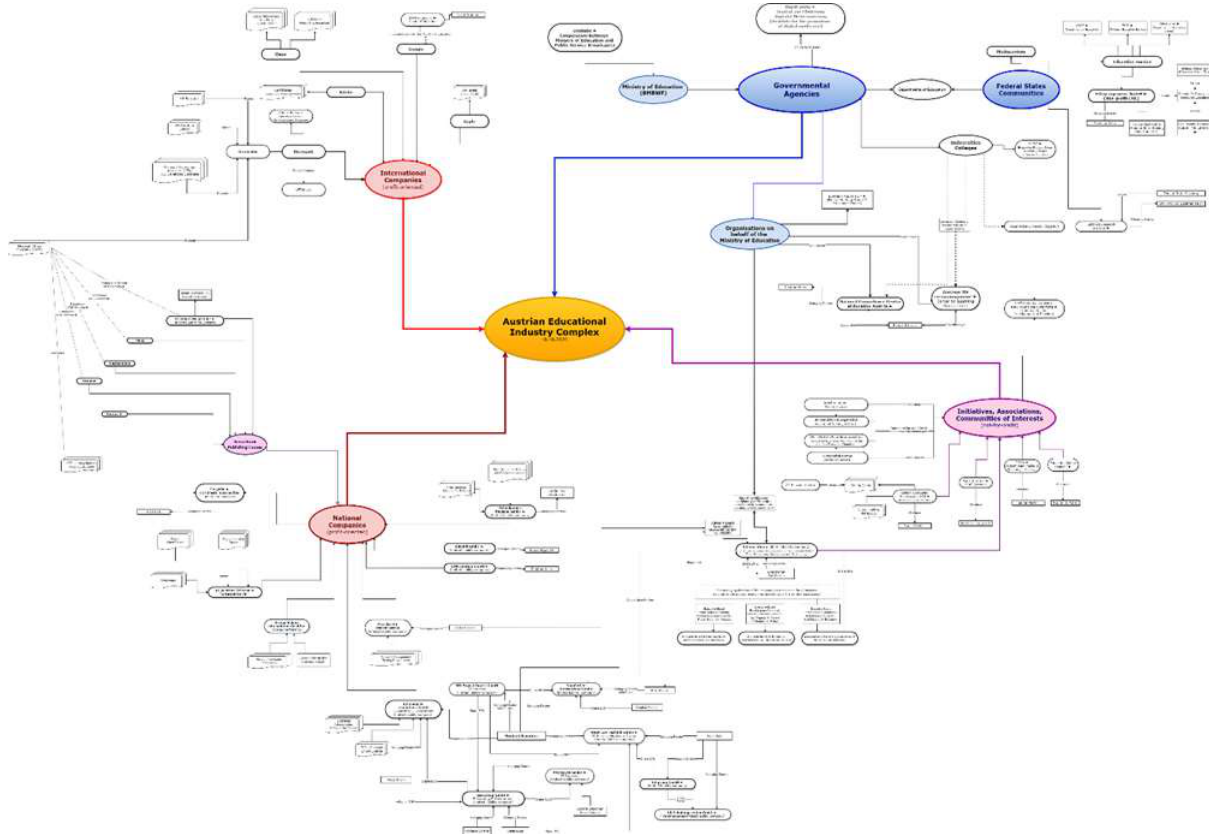
EIC in Austria (Source: authors’ representation)